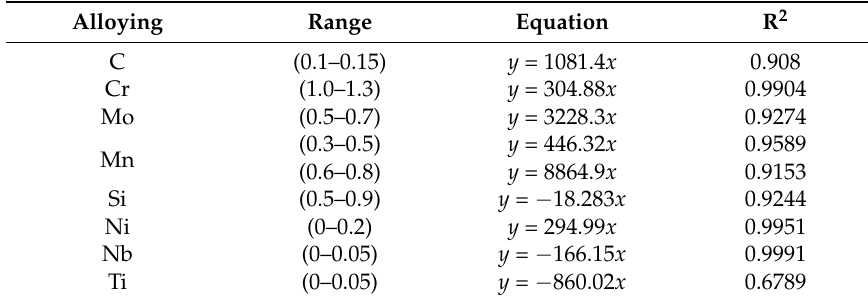
Table 2. The effects of alloying element additions on the ferrite nose time of the alloys, simulated using JMatPro